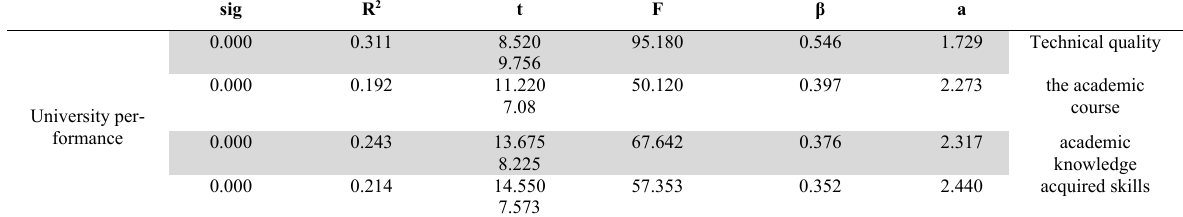
Analysis of the discrepancy between technical quality, dimensions and university